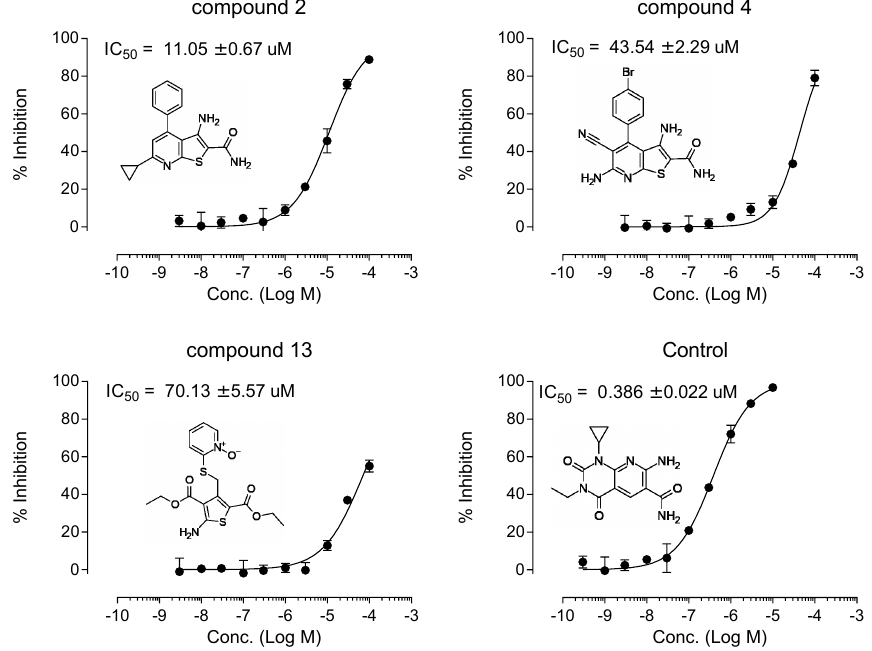
Figure 4. Dose-dependence curve of three hit compounds and A-484954 as control. The com- pound concentration required for 50% inhibition (IC 50 ) was determined from semi-logarithmic dose–response plots. Values are mean of 4